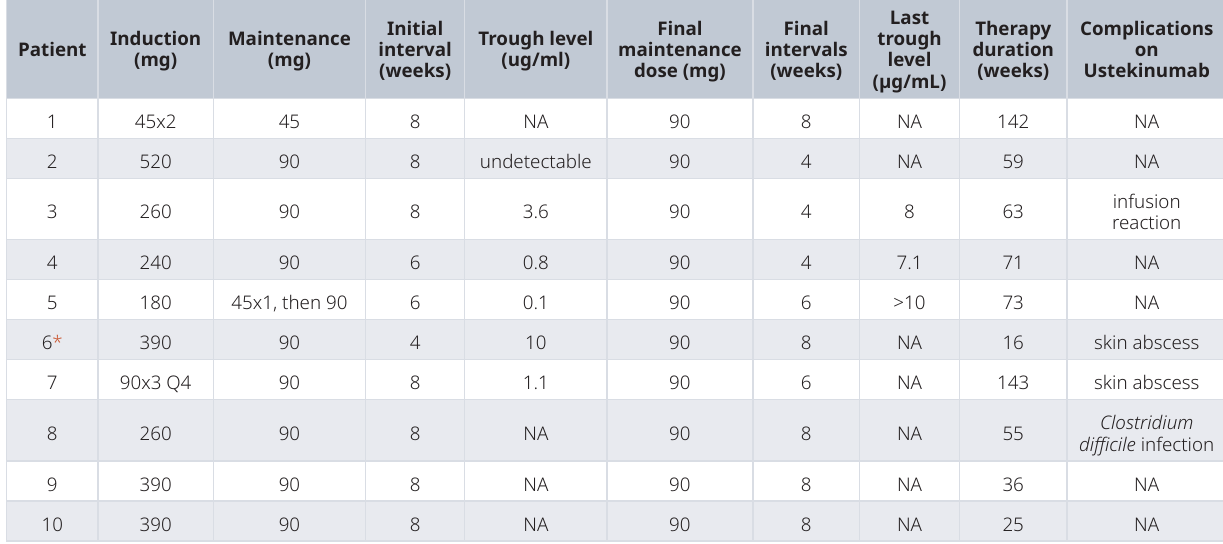
Table 2. Ustekinumab dosing, interval, levels, duration of therapy, and